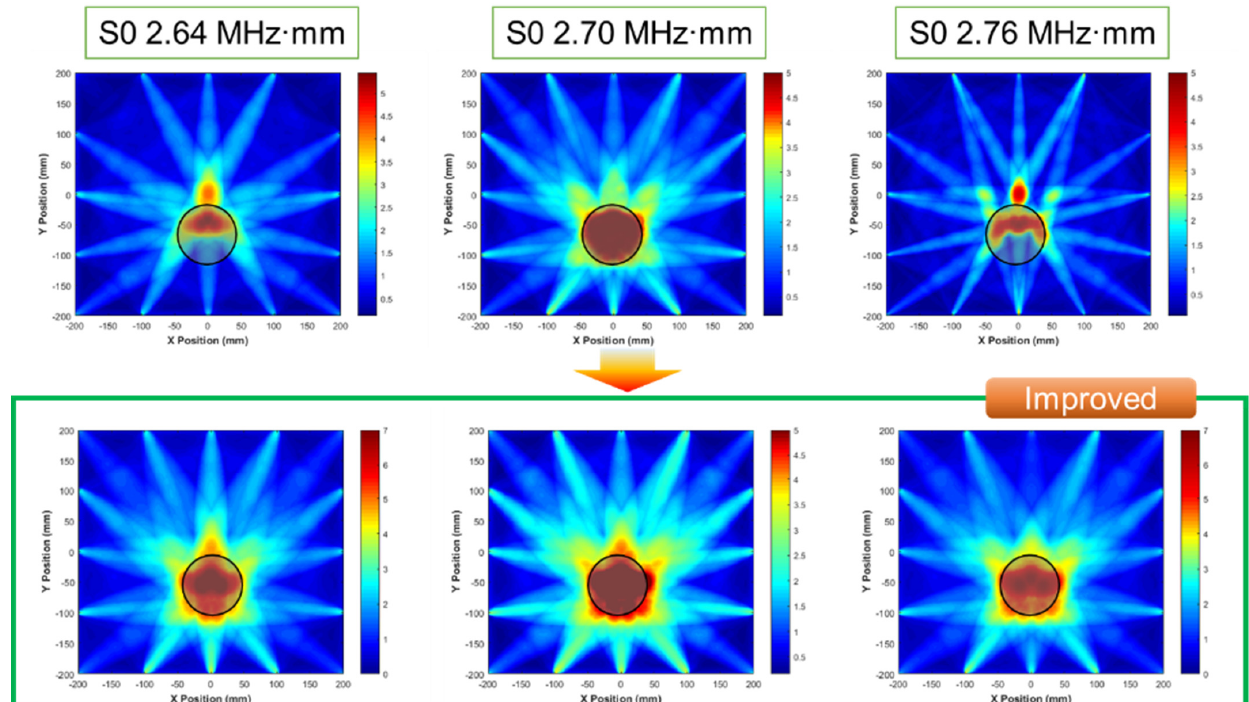
Figure 17. Modified tomography images using the proposed shape function approach by considering beam pattern anal-